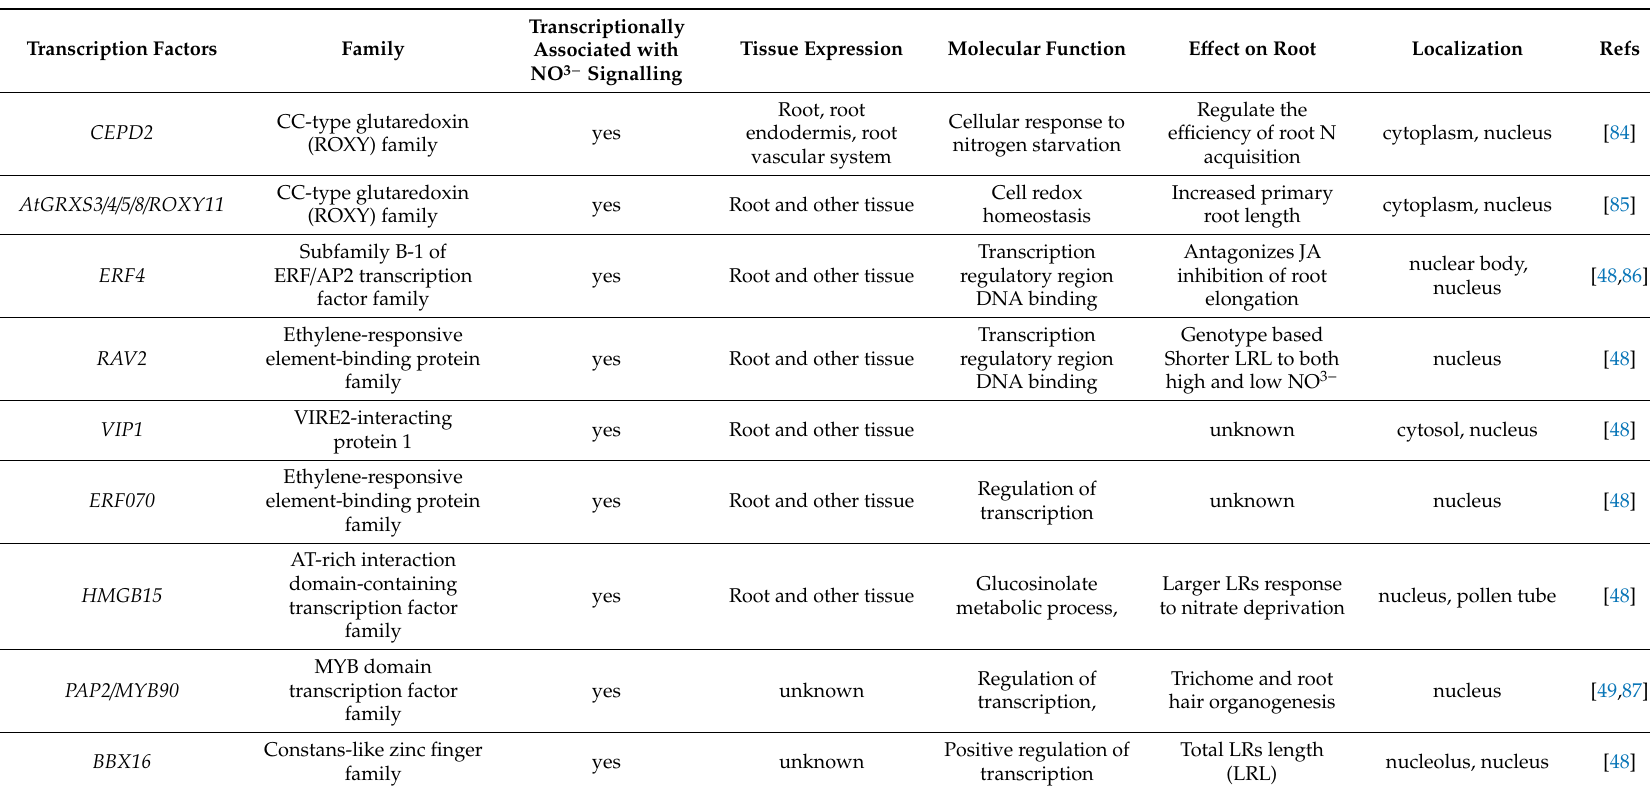
Table 1. Transcription factors of genes associated with nitrogen signaling and nitrogen-associated processes in Arabidopsis